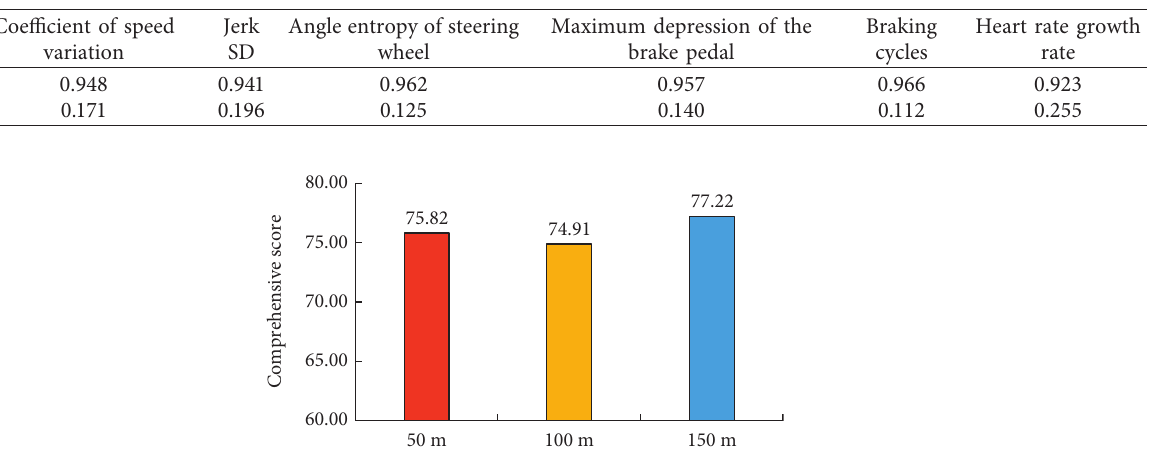
Table 5: Weights of indexes.